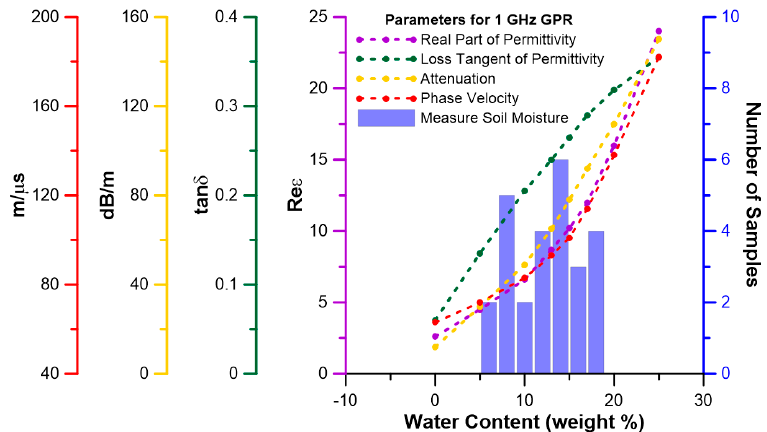
Figure 11. Measured soil moisture contents (at the time of this study) compared to variations in dielectric properties from